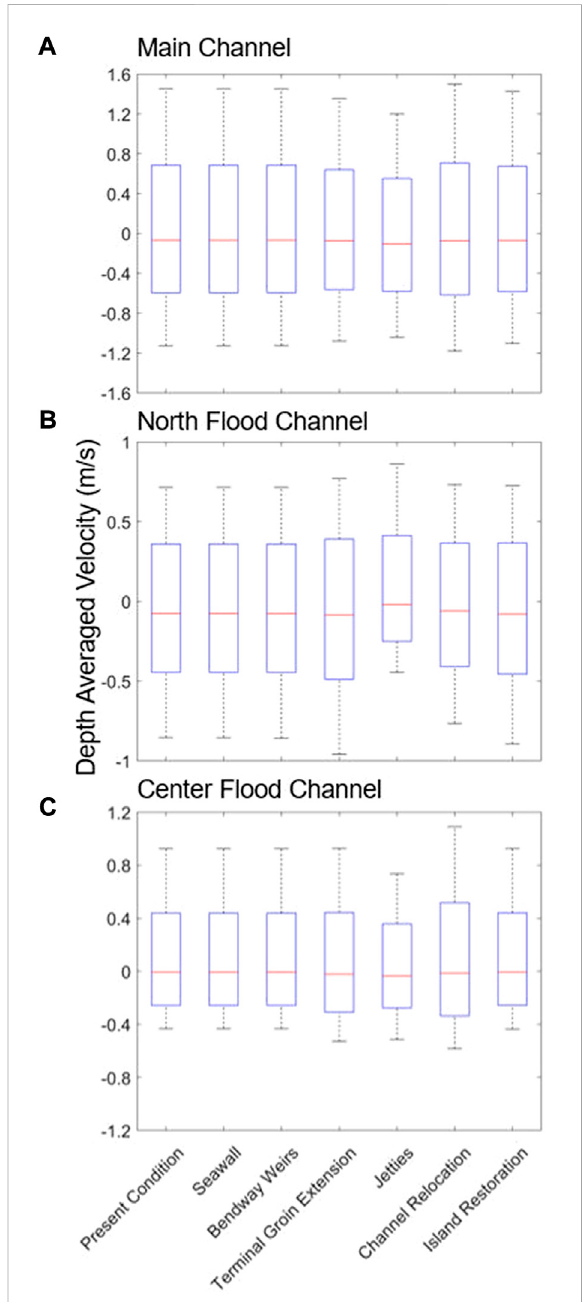
FIGURE 6 Box-and-whisker plots of depth-averaged along-channel velocity versus present condition and alternatives at the (A) main channel (B) north fl ood channel, and (C) center fl ood channel. Negative velocities indicate ebb fl ows (bay to ocean direction), while positive velocities indicate fl ood fl ows (ocean to bay direction). The horizontal red line indicates the median velocity. The vertical length of the blue boxes indicates the 25th and 75th percentiles of velocity. The black whiskers extend to the maximum and minimum